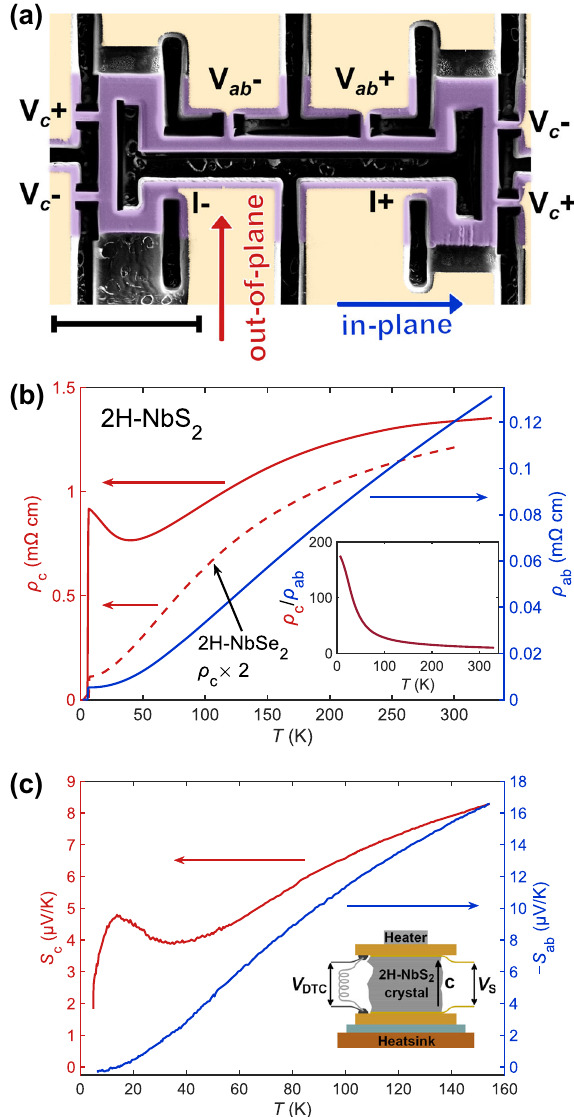
Fig. 2 Interlayer charge dynamics in 2H-NbS 2 . a Scanning electron microscope image of a 2H-NbS 2 sample, structured with focused ion beam for accurate resistivity anisotropy measurements. False colouring is used: purple – crystal, beige – gold fi lm. The scale bar in the bottom left is 20µm long. The current sourcing (I) and voltage probing (V) electrodes are labelled. b Plots of the in-plane ( ρ ab , blue) and out-of- plane ( ρ c , red) resistivities of 2H-NbS 2 against temperature ( T ). The dashed red line stands for the out-of-plane resistivity of 2H-NbSe 2 , scaled by a factor of 2. Resistivity anisotropy of 2H-NbS 2 is plotted in the inset. c Seebeck coef fi cients of 2H-NbS 2 for the out-of-plane ( S c ) and in-plane ( S ab ) directions as functions of temperature, measured on bulk single crystals (note that S ab is negative). The setup for measuring S c is illustrated schematically. The crystal was approximately 1mm long in the c axis direction (indicated in the drawing), and 2 – 3mm long laterally. The value of S c is the ratio of the voltage across the sample ( V s ) and the thermal gradient across it, determined from the differential thermocouple voltage ( V DTC ). The sample sat between two copper plates, which homogenised temperature at its two faces and was electrically decoupled from the heatsink by a thin sapphire